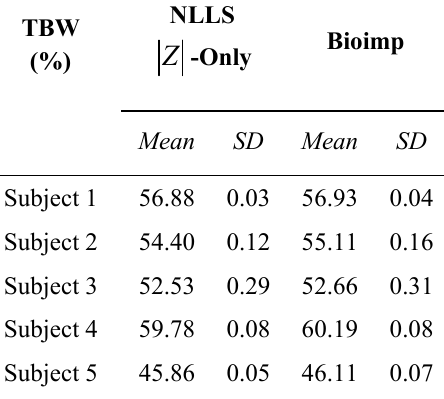
Table IV. Mean and Standard Deviation of